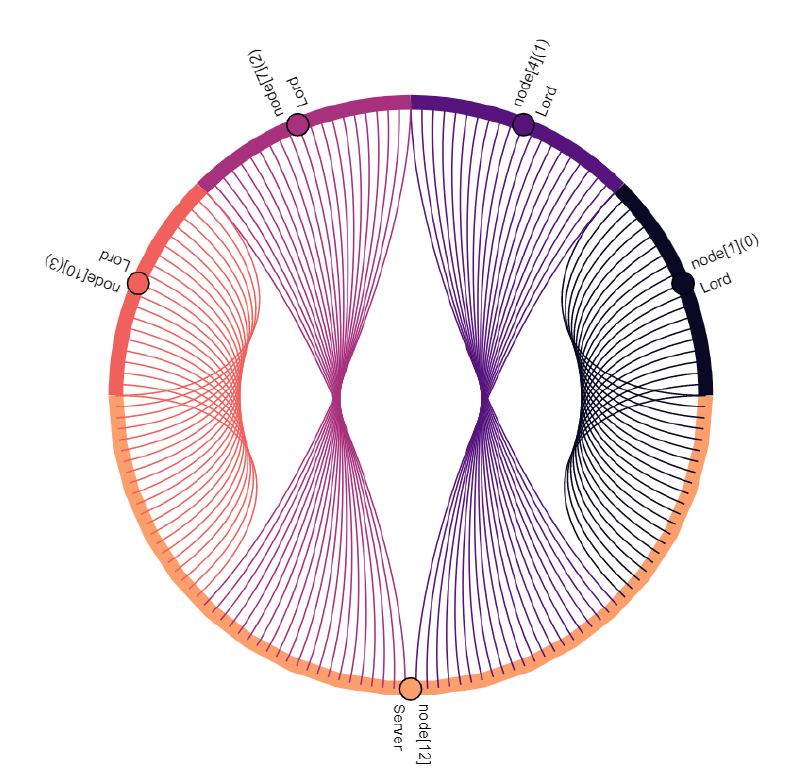
Figure 10. Lords ship vassalage data to central